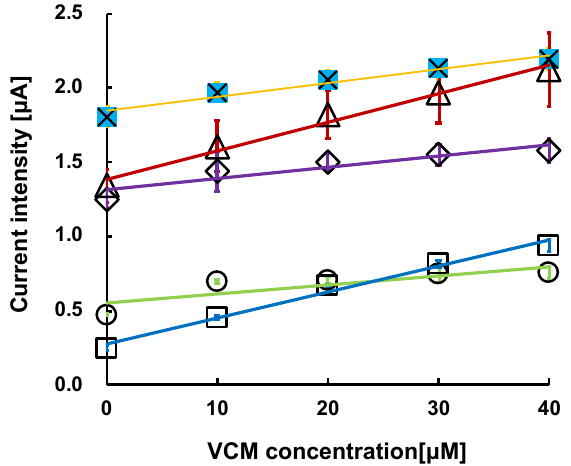
Figure 9. Relationship between current intensity at 0.80 V vs. Ag/AgCl with MIP grafted (including ACPF) and the VCM concentration in PBS (blue square), whole blood (red triangle), plasma (purple diamonds), washed blood cell suspension solution (green circles), and deproteinized plasma (blue squares with crosses). Table 3. Sensitivity to VCM and the background current intensity at the MIP-ITO electrode (including ACPF) in each solvent.